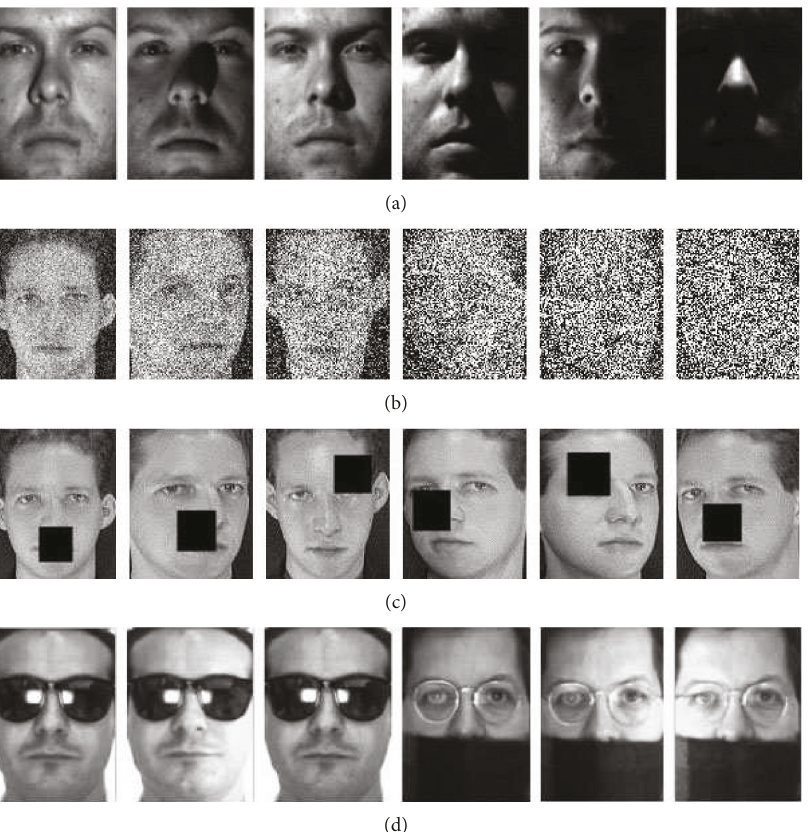
Figure 1: Sample images. (a) Extended YaleB dataset, (b) ORL dataset with random pixel corruption, (c) ORL dataset with random block occlusions, and (d) AR dataset with contiguous occlusions by sunglasses and